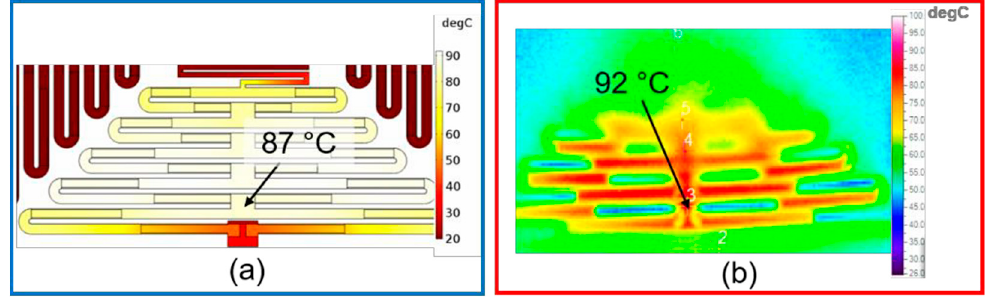
Figure 4. Thermal steady state results of the actuation assembly where one actuator was biased with 20 mA (Joule Heating): ( a ) FEM Model and ( b ) experimental. The experimental result was obtained using the infrared camera being focused on a selected location on the